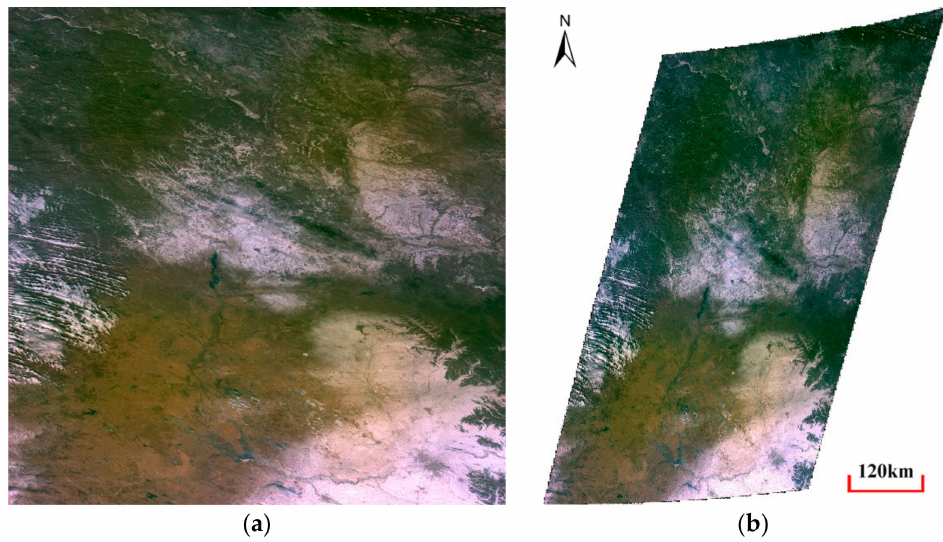
Figure 4. Shape of the original Level 1A image ( a ) and its orthorectification image ( b ) in the northeast of